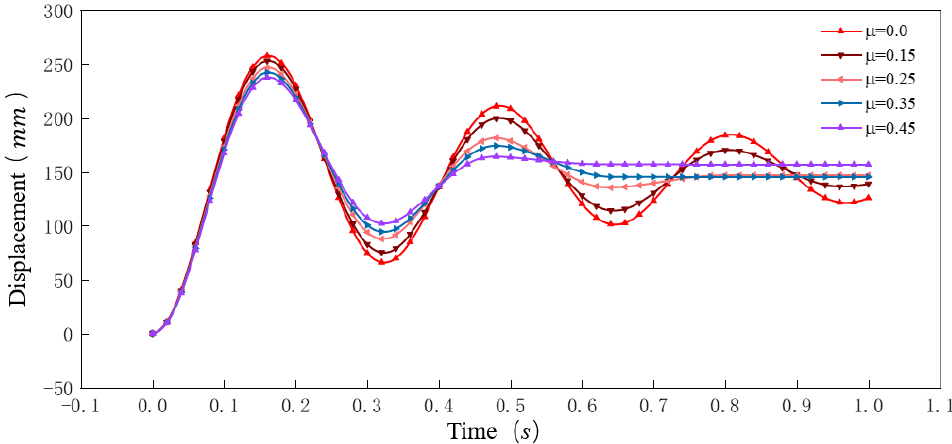
Figure 7. The sliding core movement displacement changes with friction coefficient.